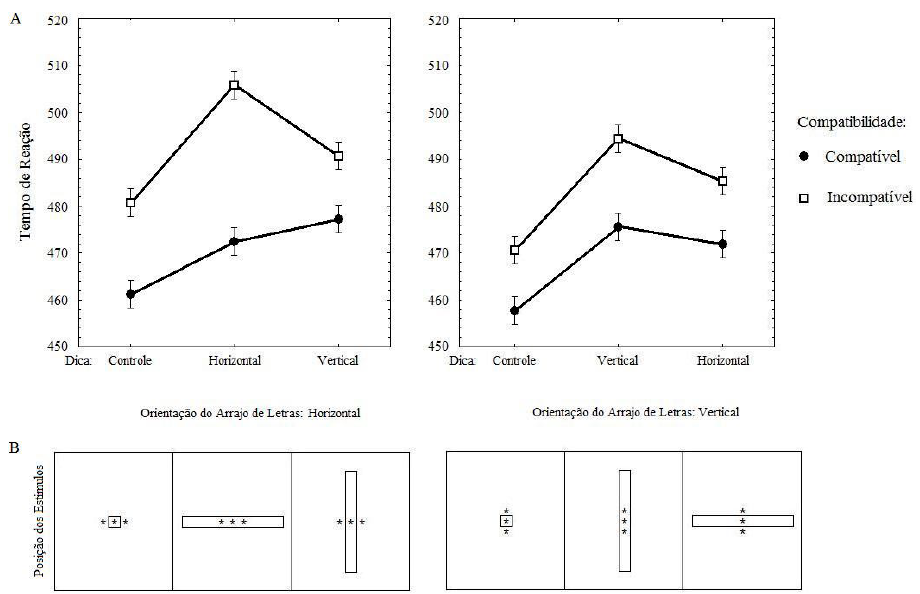
Figura 4. A- Tempo de reação médio (TR) em função do tipo de dica (controle, horizontal, vertical); orientação do arranjo de letras (horizontal, vertical) e compatibilidade entre letra alvo e letras flanqueadoras (compatível e incompatível). B- Representação esquemática dos tipos de dica e da posição ocupada pelos arranjos de letras